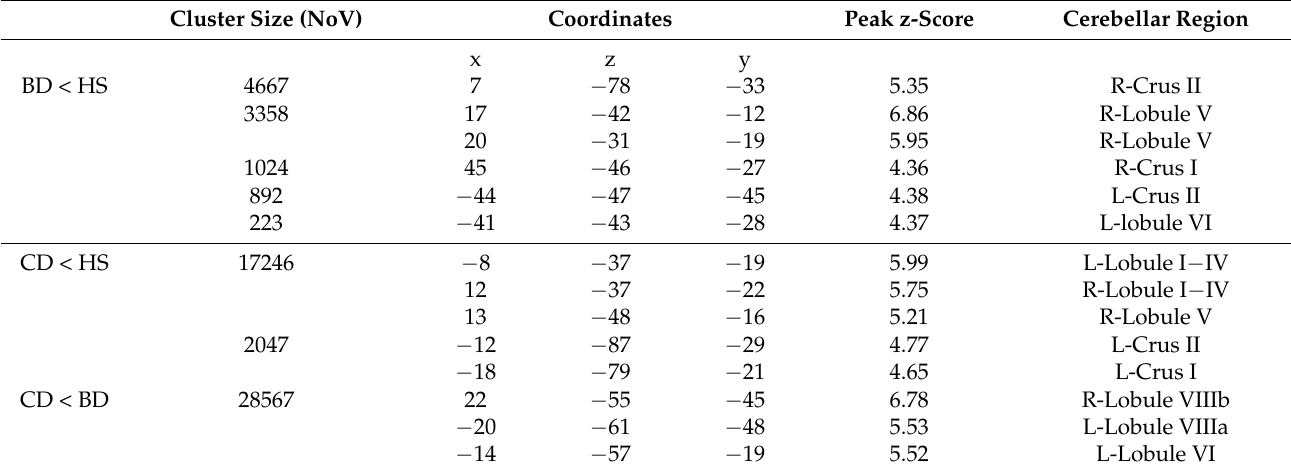
Table 2. Cerebellar voxel-wise analyses between BD patients, CD patients and HSs. Detailed statistics and z-scores of peak voxels showing greatest statistical significance in the cluster. Cluster-forming threshold p < 0.05 FWE.